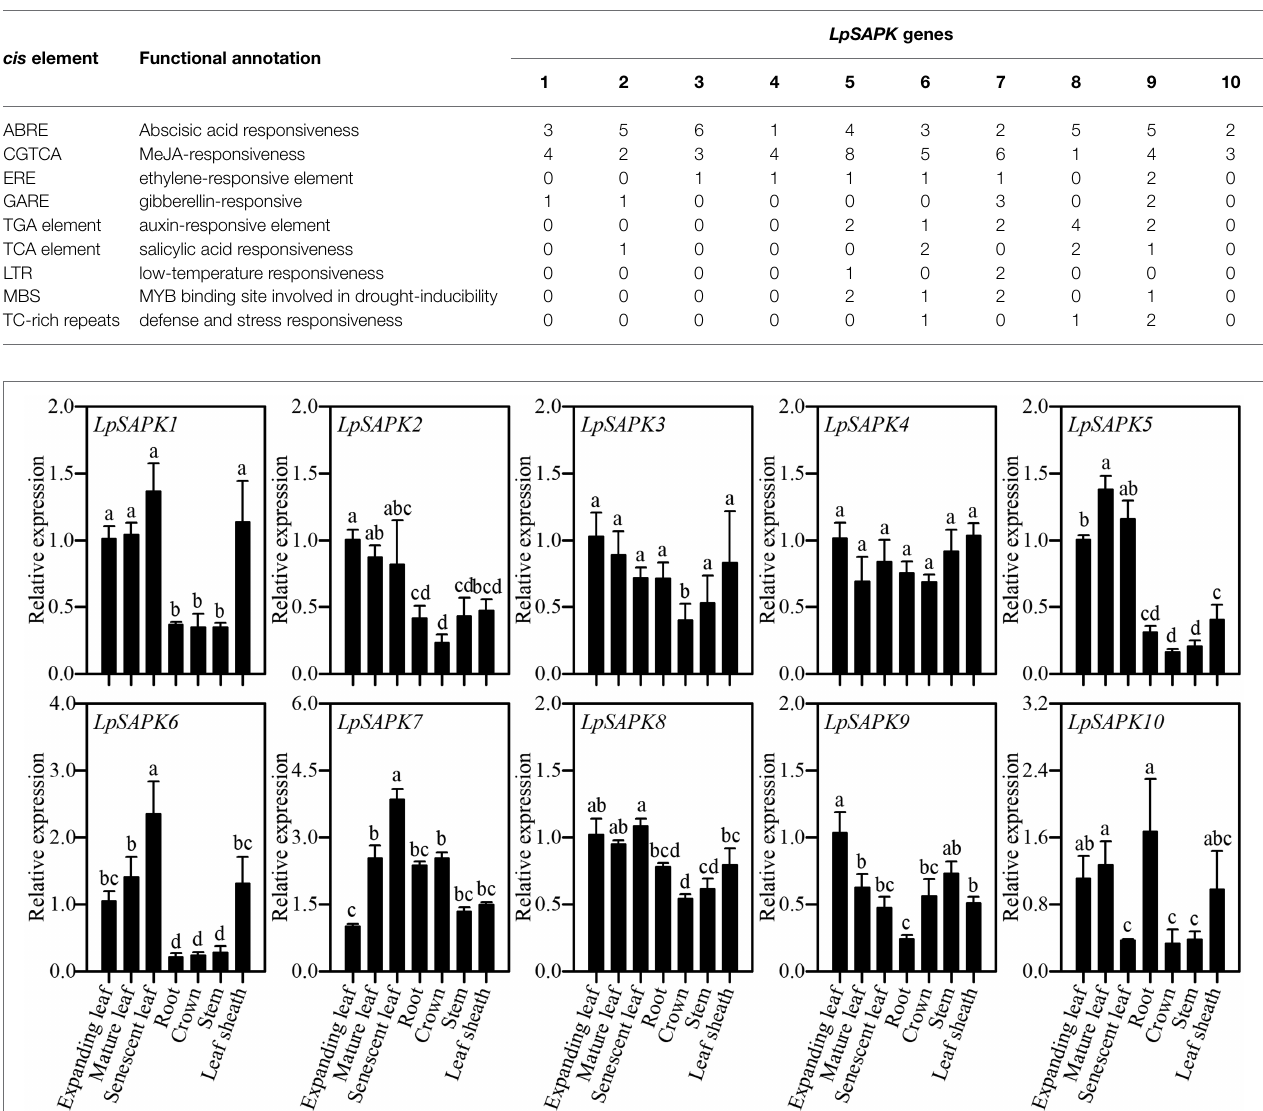
TABLE 2 | The cis element analysis of LpSAPKs promoter regions.